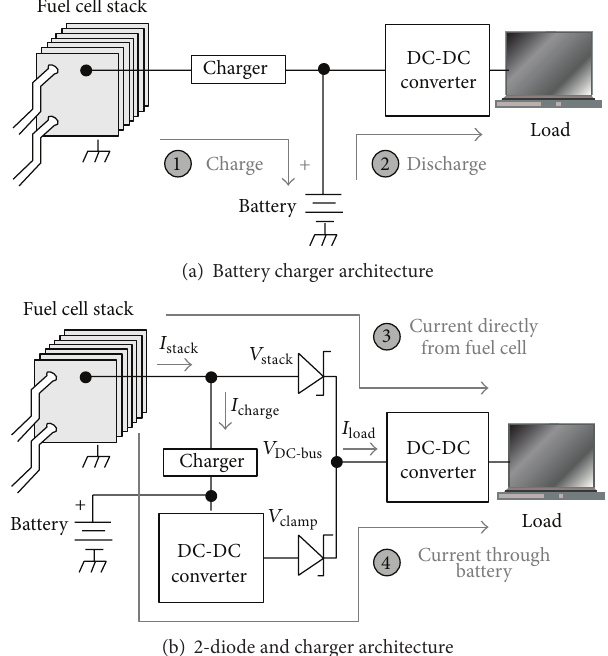
Figure 4: Power control scheme for fuel cell and battery hybrid, Chang et al.